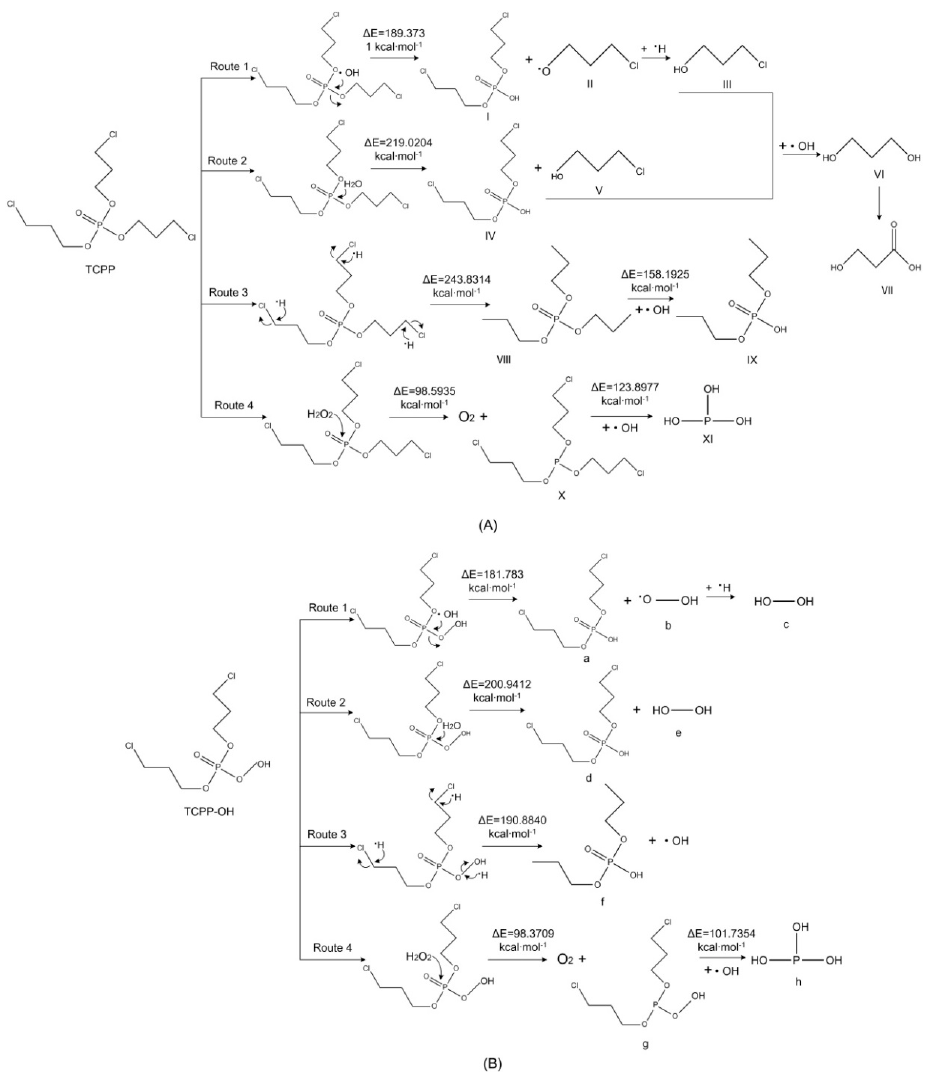
Figure 4. Proposed photodegradation pathways of TCPP before ( A ) and after modification ( B ).